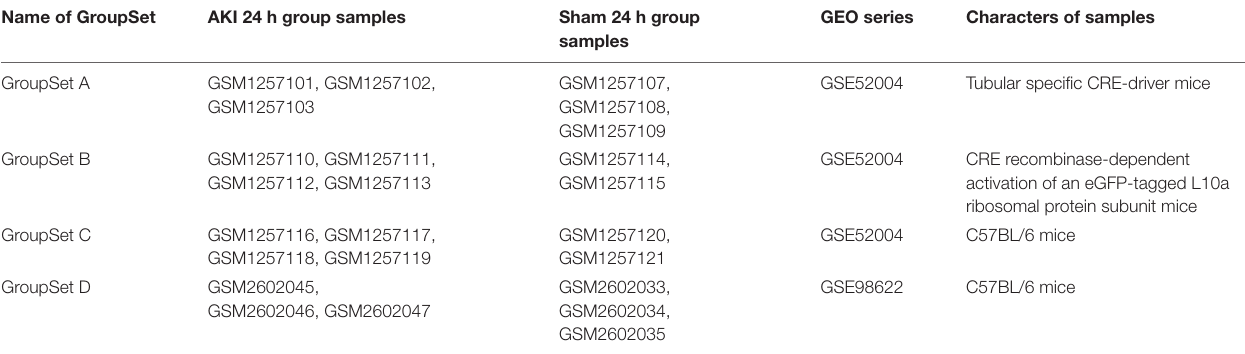
TABLE 1 | Details for GroupSet extracted from two AKI